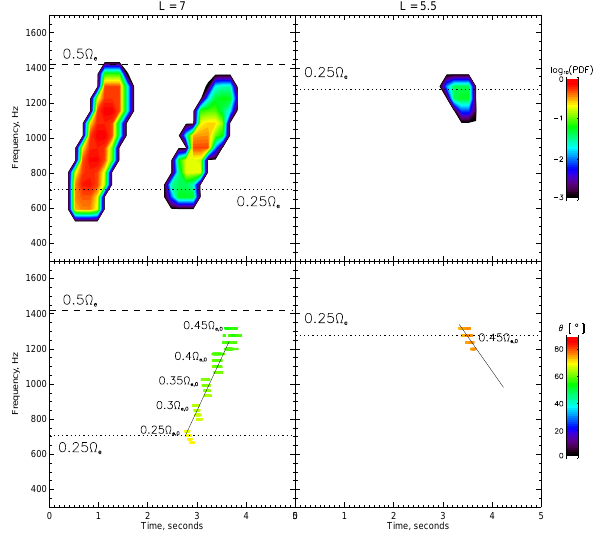
Figure 2. Time-frequency power spectra (top panels) of source and reflected chorus elements and their internal structure (bottom pan- els) as a function of θ angle (color), obtained from numerical sim- ulations, recorded at the equator in two different regions L = 7 (source) and L = 5 . 5. In each panel, the dashed black line repre- sents 0 . 5 (cid:127) e and the dotted line represents 0 . 25 (cid:127) e . Initial ray fre- quencies normalized to (cid:127) e, 0 are shown by text. The solid black line shows the sweep rate of each reflected element.